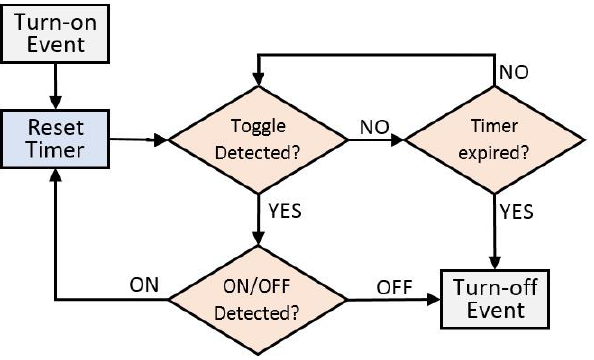
Figure 7. Auxiliary timer implemented as a watchdog timer. The timer loop is initiated by a turn-on event and terminated by a turn-off event.